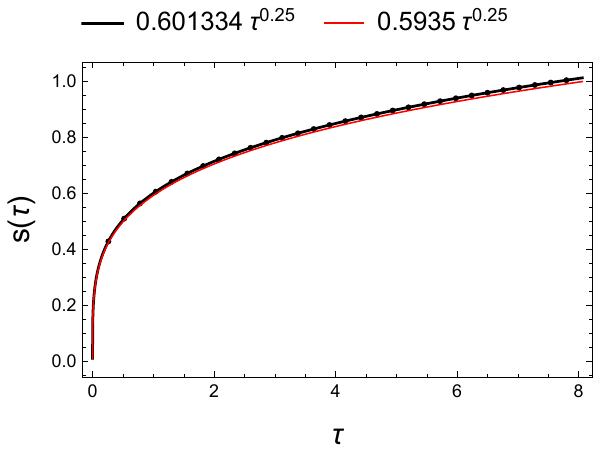
Figure 9. Numerical solution of S for α = 0.5, λ 1 = 1, λ 2 = 2, κ 1 = 1, κ 2 = 1.